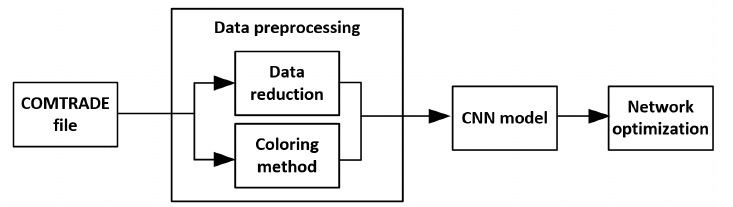
Figure 1. Block diagram of CNN-based fault classification using COMTRADE